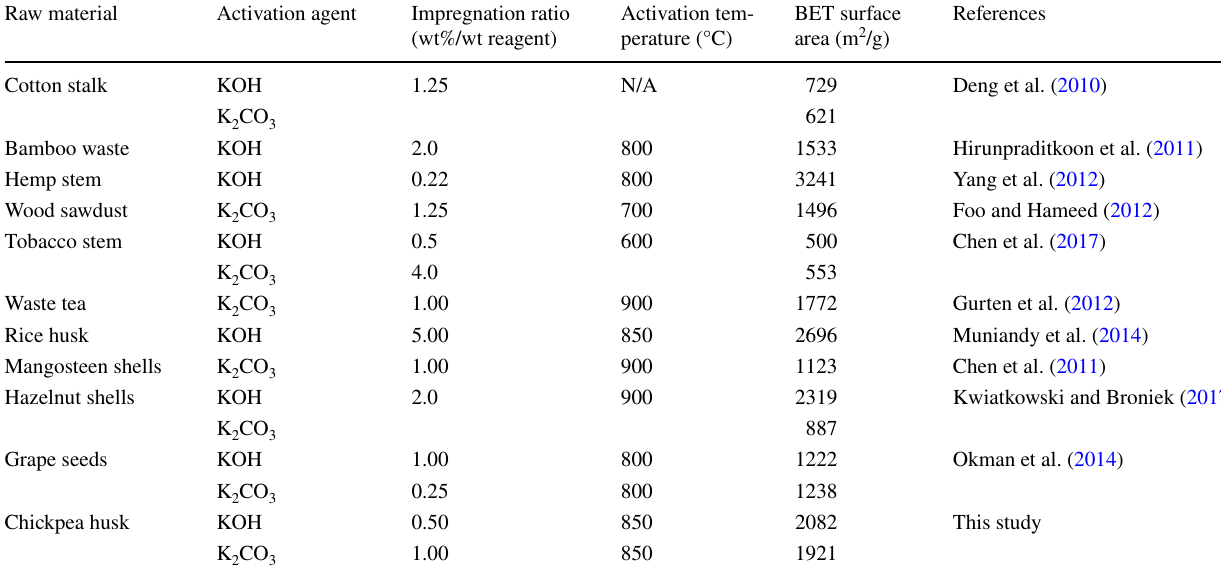
Table 3 BET surface areas of different biomass-based activated carbons Raw